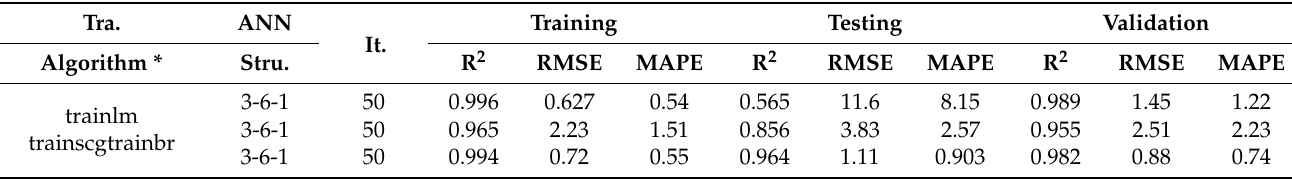
Table 4. Comparison of ANN models for the estimation of